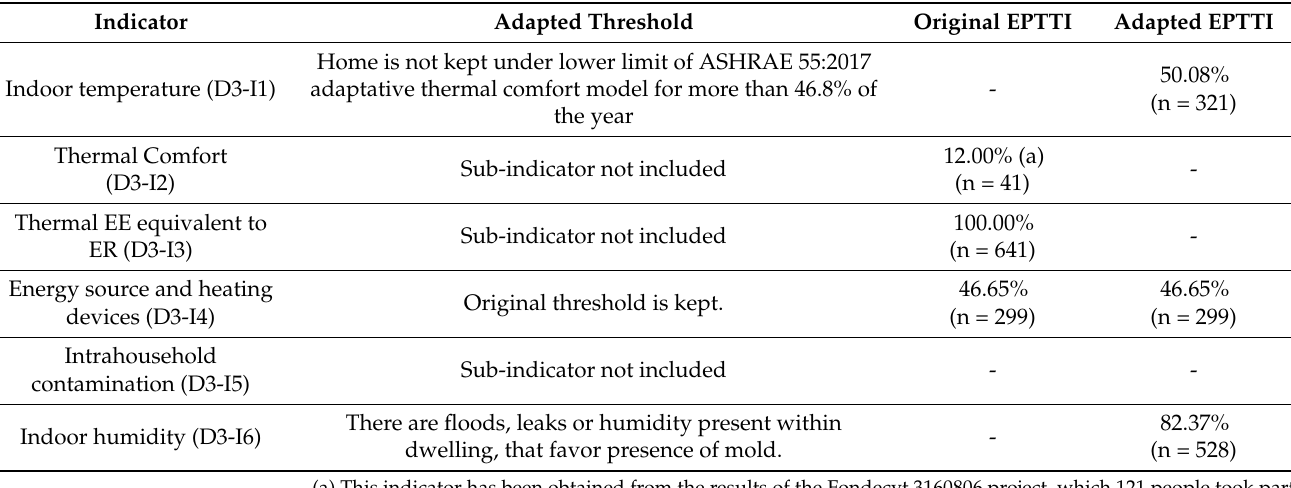
Table 7. Comparison of D3’s indicators between original and adapted EPTTI.